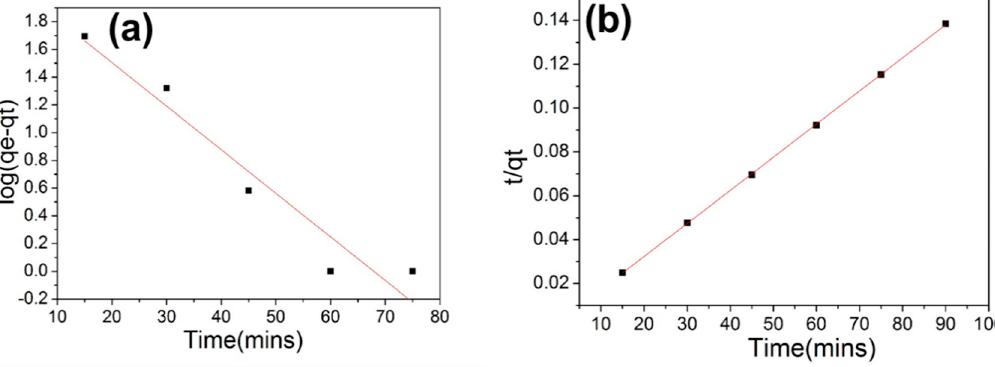
Figure 7. Adsorption kinetics of Ni 2 + ions on gauze@PEI 0.4 / PEGDE 1 / TETA 0.6 fitted in ( a ) pseudo first-order model and ( b ) pseudo second-order model. Table 2. Parameters used for the kinetic model.